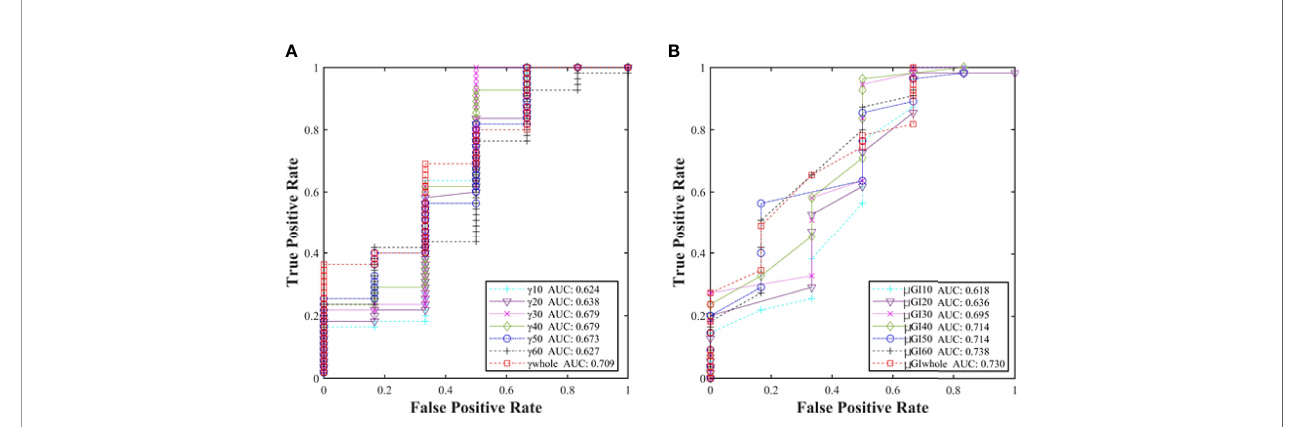
FIGURE 7 | (A) Comparison of the AUCs of %GP in different regions ( g whole , g 10% , g 20% , g 30% , g 40% , g 50% , and g 60% ) and (B) m GI ( m GI whole , m GI 10% , m GI 20% , m GI 30% , m GI 40% , m GI 50% , and m GI 60% ).